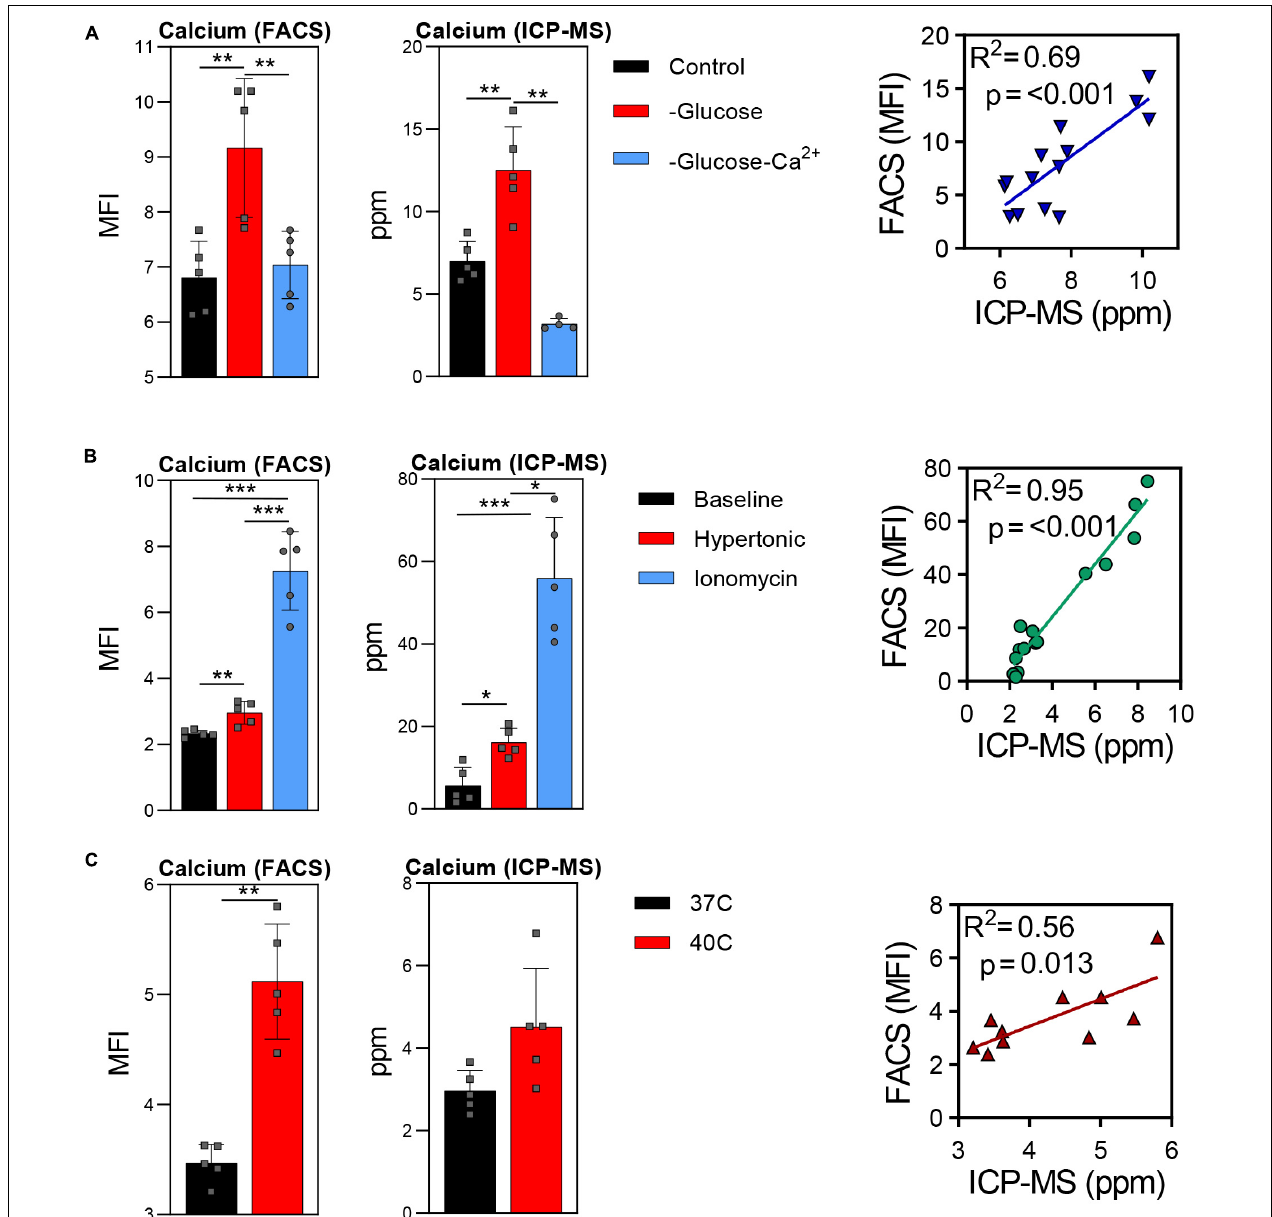
FIGURE 3 | Comparison of calcium measurements via fluorescence-based approaches vs. ICP-MS in red blood cells after starvation (A) , ionic stress (B) , or heat stress (C) . * p < 0.05; ** p < 0.01; *** p <